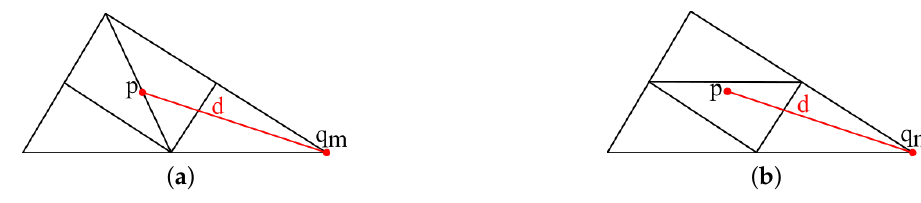
Figure 10. Two types of triangle 1 to 4 refinements with appropriate d. ( a ) 1:4 Longest-edge bisection,